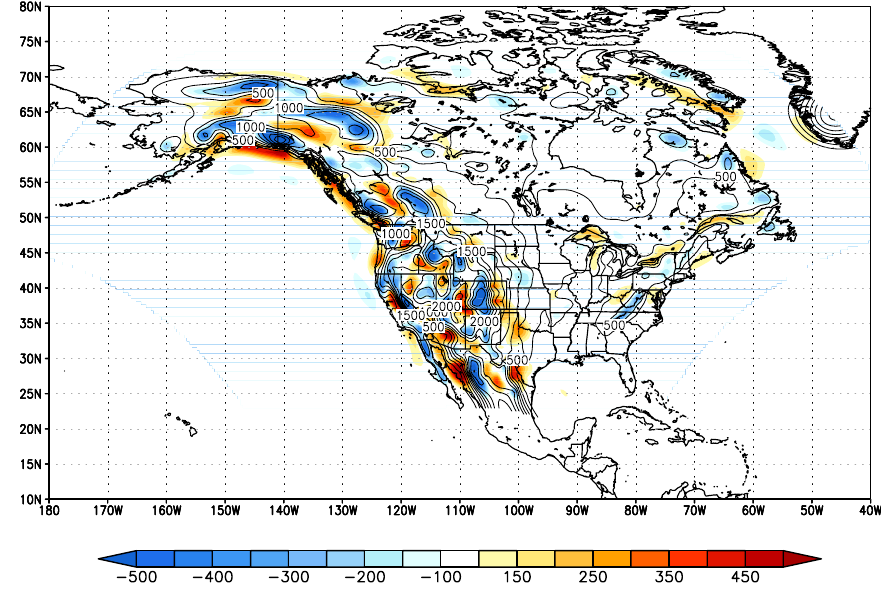
Fig. 2. Difference in the orography of the RSM and the GFS models. Thin contours show the height of the orography in the RSM model, while color shades show the height of the orography in the GFS model minus the height of the orography in the RSM.